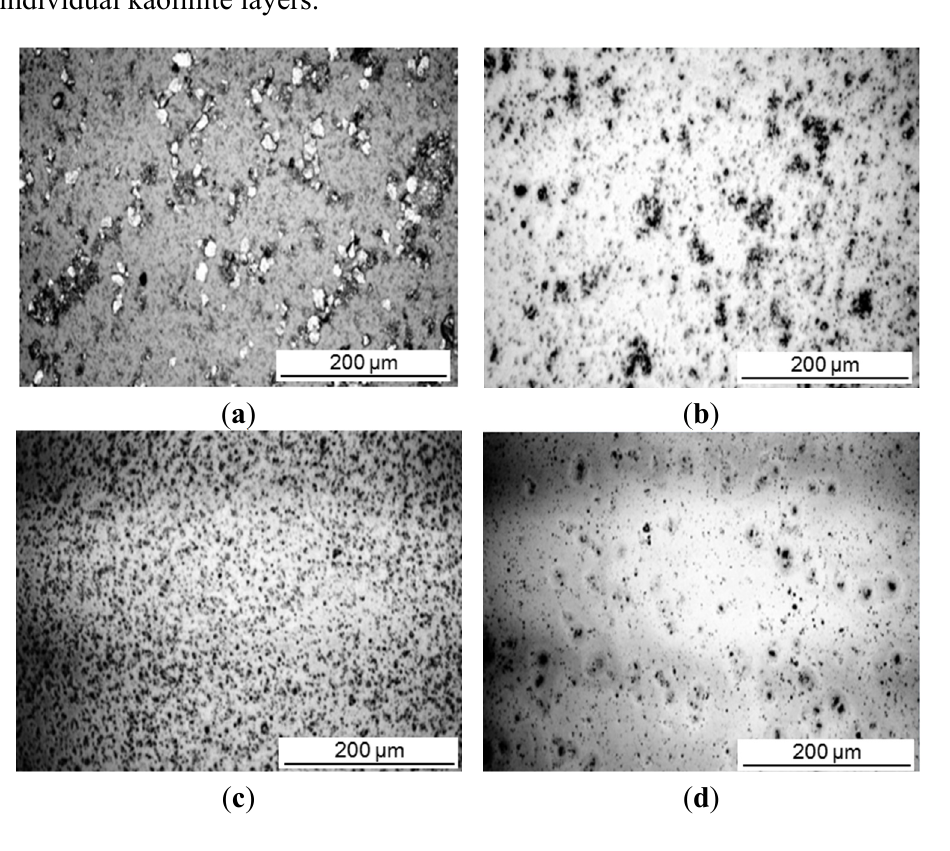
Figure 3. Optical microscopy representing size distribution of intercalated kaolinite particles, ( a ) Kln/DMSO + water, ( b ) Kln/a-SMA = 80:20, ( c ) Kln/a-SMA = 70:30, ( d ) Kln/a-SMA = 50:50.